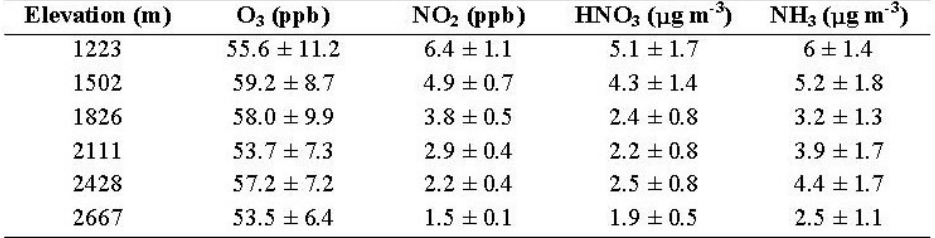
Summer Means (June 15 to September 20) of Different Air Pollutants along the Elevation Gradient in the San Bernardino Mountains during Summer 2000 (Means ±